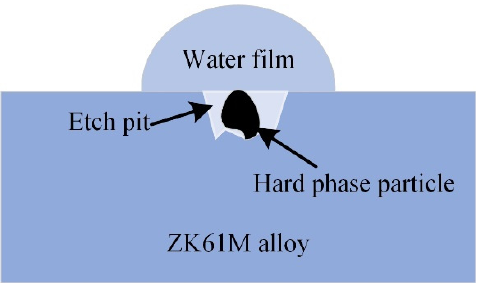
Figure 17. Schematic diagram of initial pitting corrosion mechanism.